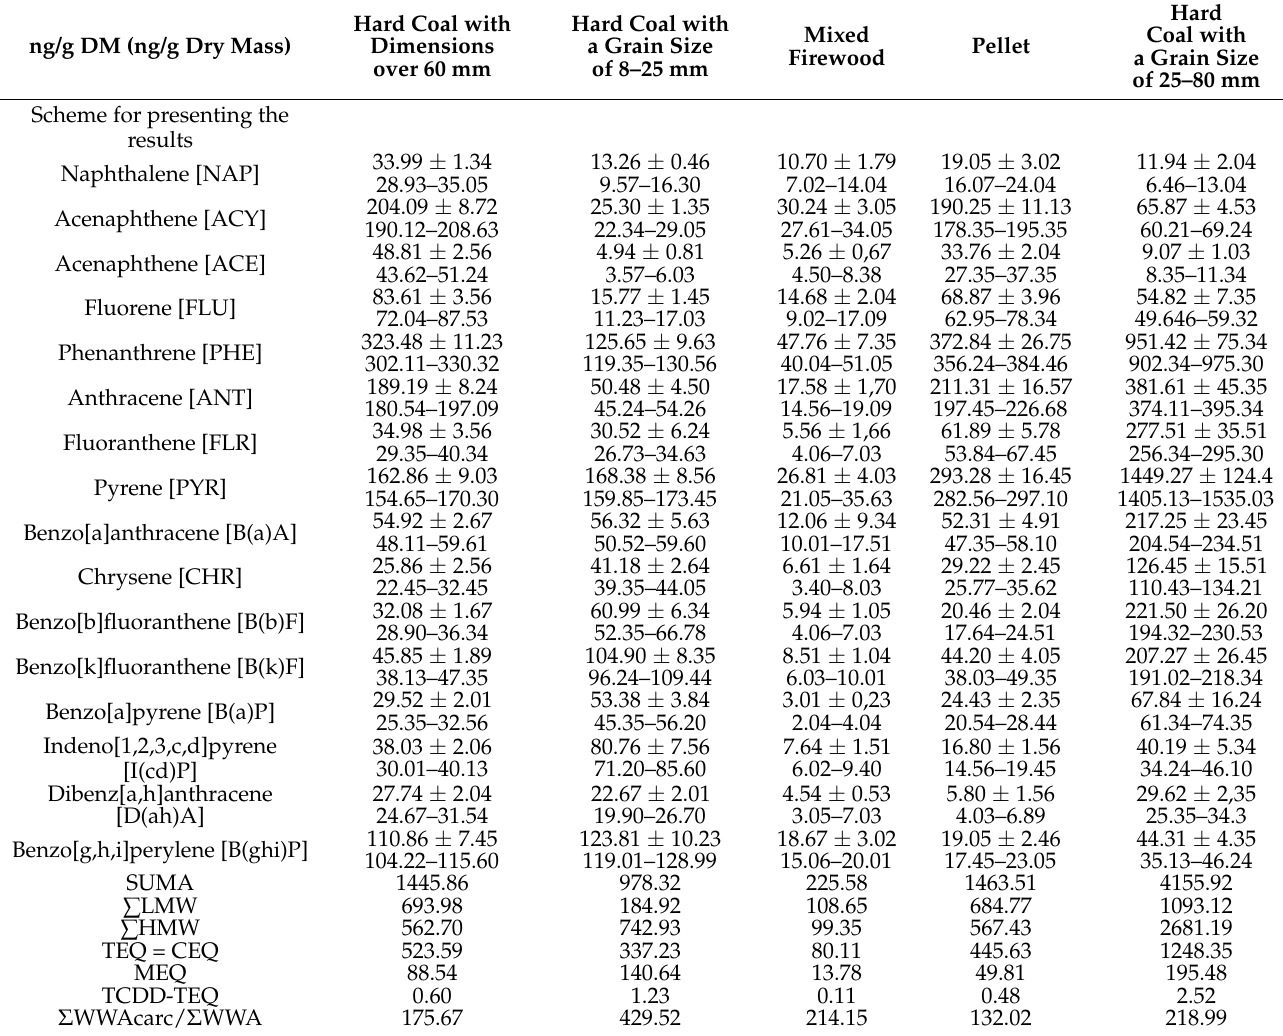
Table 2. PAH in eluents from soot and fly ash samples and calculated